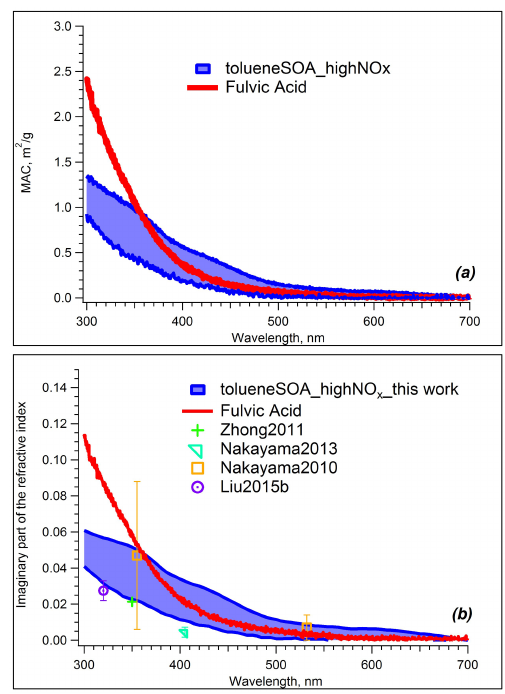
Figure 3. (a) MAC values of Suwanee River fulvic acid (SRFA), and toluene SOA formed at different high-NO x conditions. (b) Imaginary part of the refractive index, k , derived from toluene high-NO x SOA measurements through the 300–700nm range, with SRFA and literature data as references (Nakayama et al., 2010, 2013; Liu et al., 2015b; Zhong and Jang, 2011). SRFA k values were estimated assuming a density of 1.47gcm − 3 (Dinar et al., 2006).